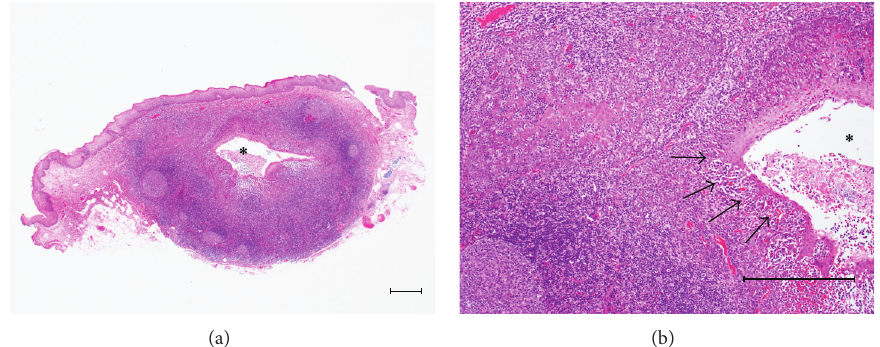
Figure 2: (a) Histopathological findings of Case 1. Germinal center, lymphoid tissue, and a crypt ( ∗ ) are seen (Hematoxylin-Eosin (HE), scale bar = 250 𝜇 m). (b) Lymphoepithelial symbiosis in the crypt is seen (arrows) (HE, scale bar = 250 𝜇 m).